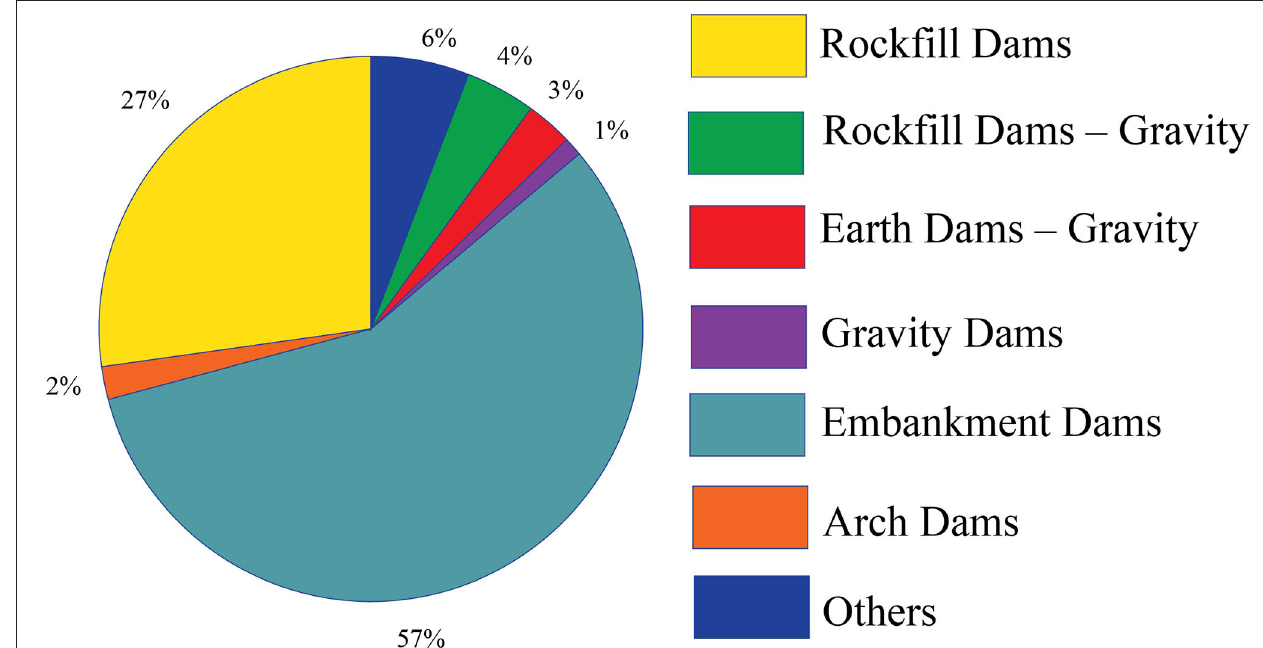
FIGURE 2 | Distribution of the main type of dams in Venezuela. Source: Adapted of FAO (2015a).